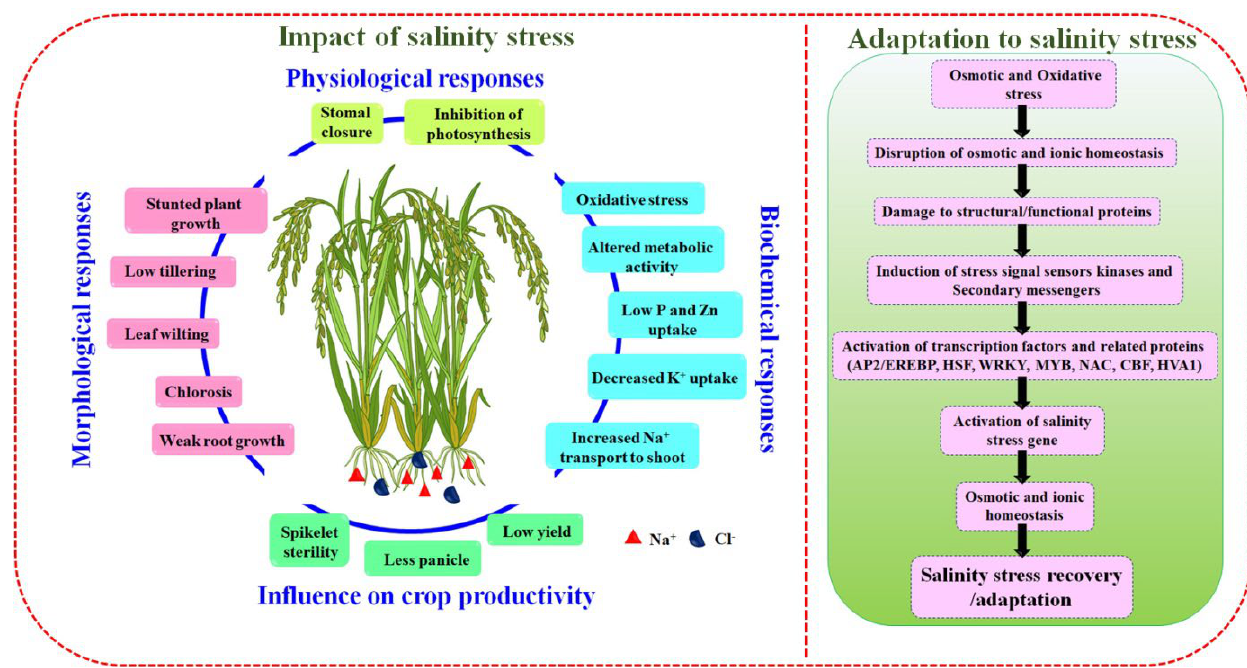
Figure 2. Impact and adaptation of salinity stress in rice.